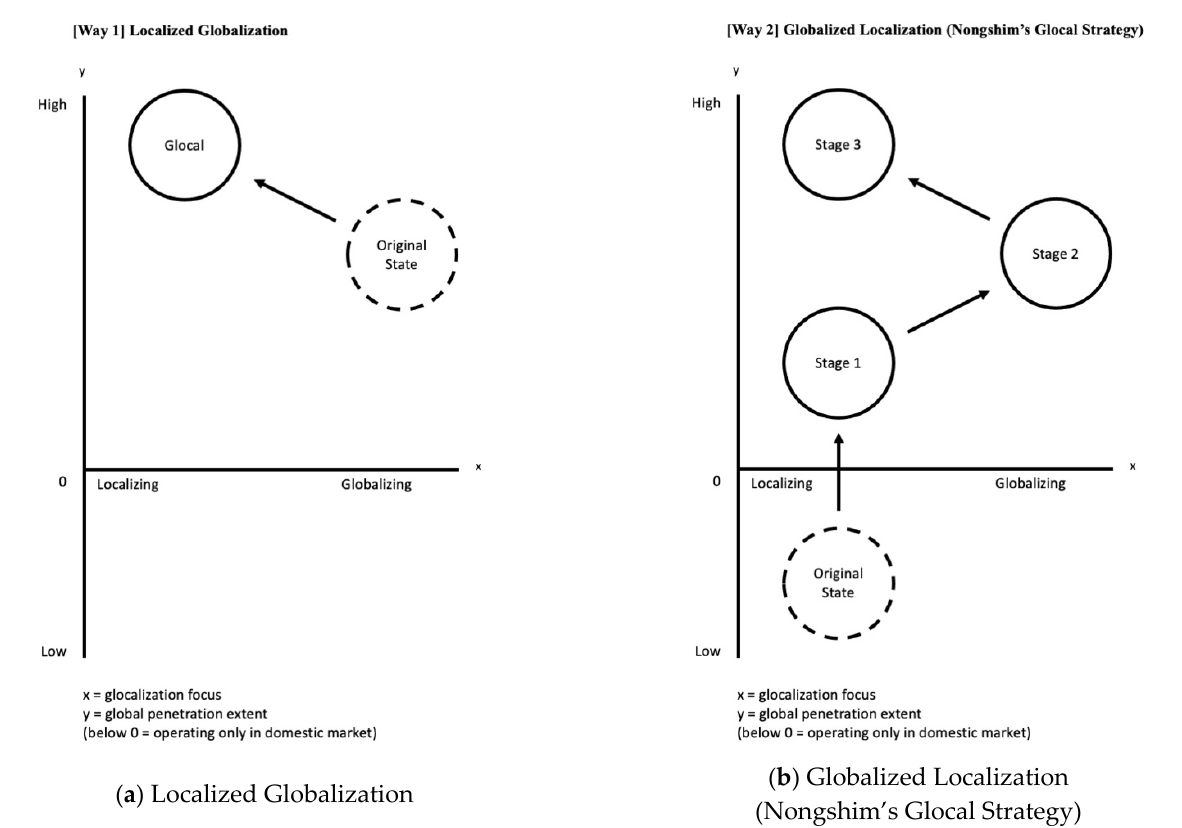
Figure 1. Theoretical Framework of Corporate Glocalization.